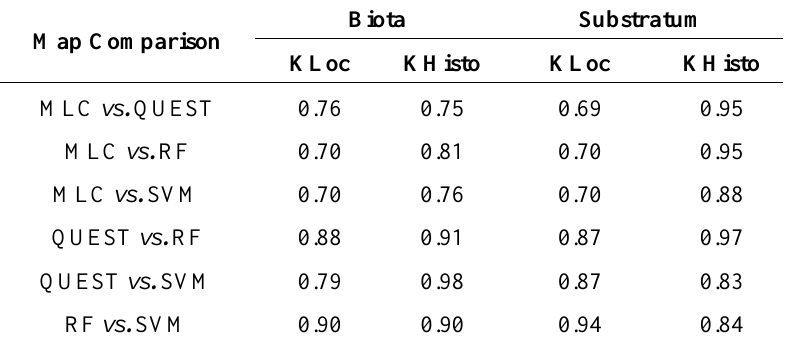
Table 3. Results from habitat map comparisons. KLoc = measure for the similarity of spatial allocation, KHisto = measure for the quantitative similarity. MLC = Maximum Likelihood Classifier, QUEST = QUEST decision tree, RF = Random Forest decision tree, SVM = Support Vector Machine. Biota Substratum Map Comparison KLoc